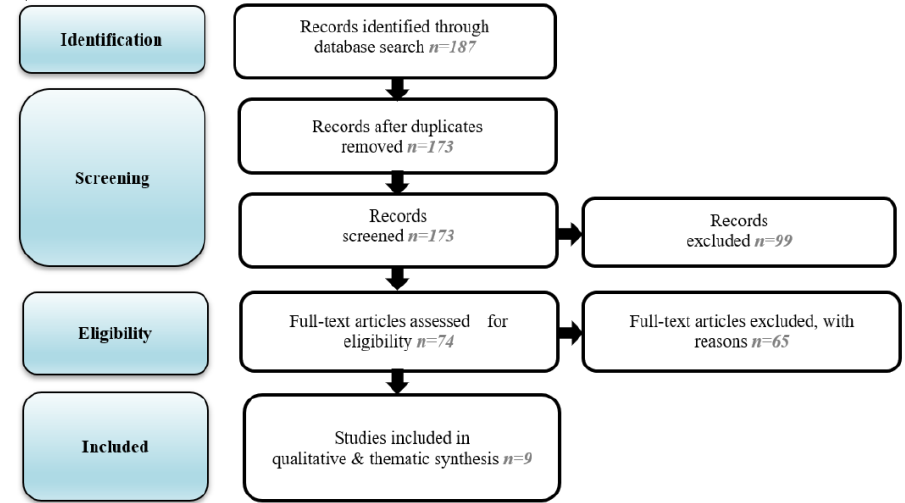
Figure 1: Selection of the Studies in this Systematic Review for Striking a Balanced between Centralized and Decentralized Decision-Making in School Management.